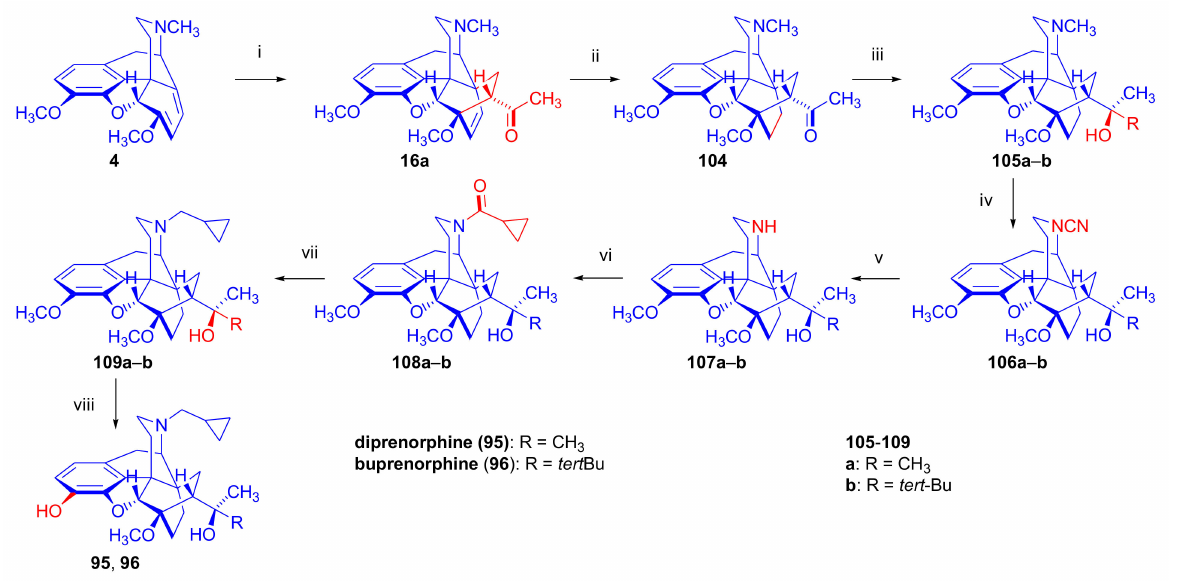
Figure 33. The first synthesis [74,97,111] of diprenorphine and buprenorphine. Reagents and conditions